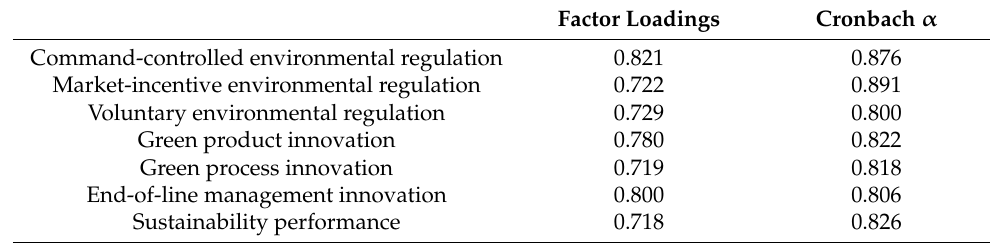
Table 2. Factor loadings and Cronbach α